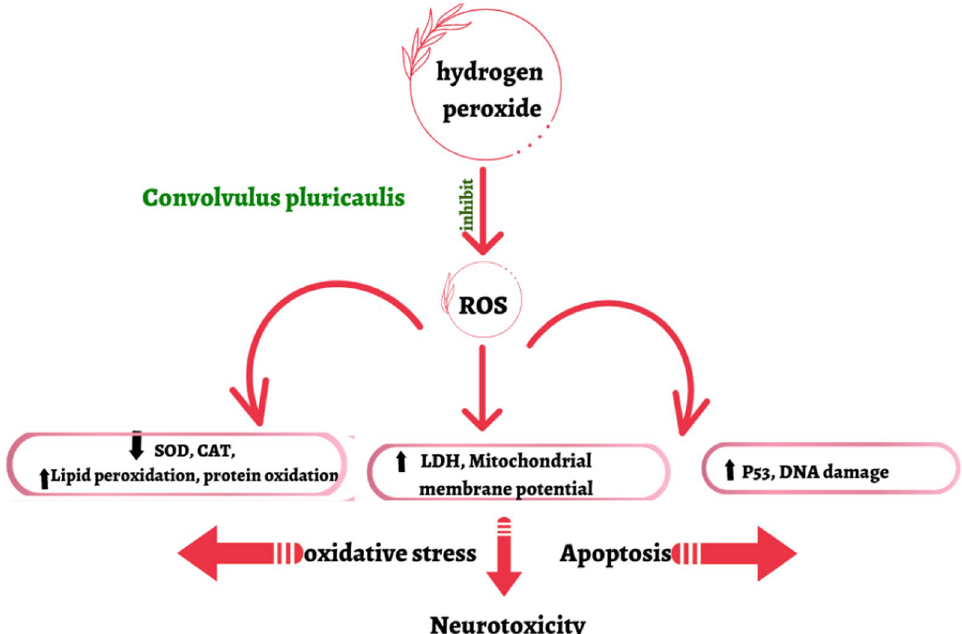
Fig. 6 Anti-oxidant and anti-apoptotic activity of Convolvulus pluricaulis against H 2 O 2 -induced neurotoxicity on SH-SY5Y human brain cells mediates its neuroprotective